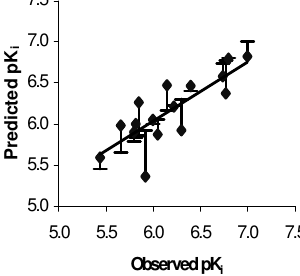
Figure 2. Plot between observed pK